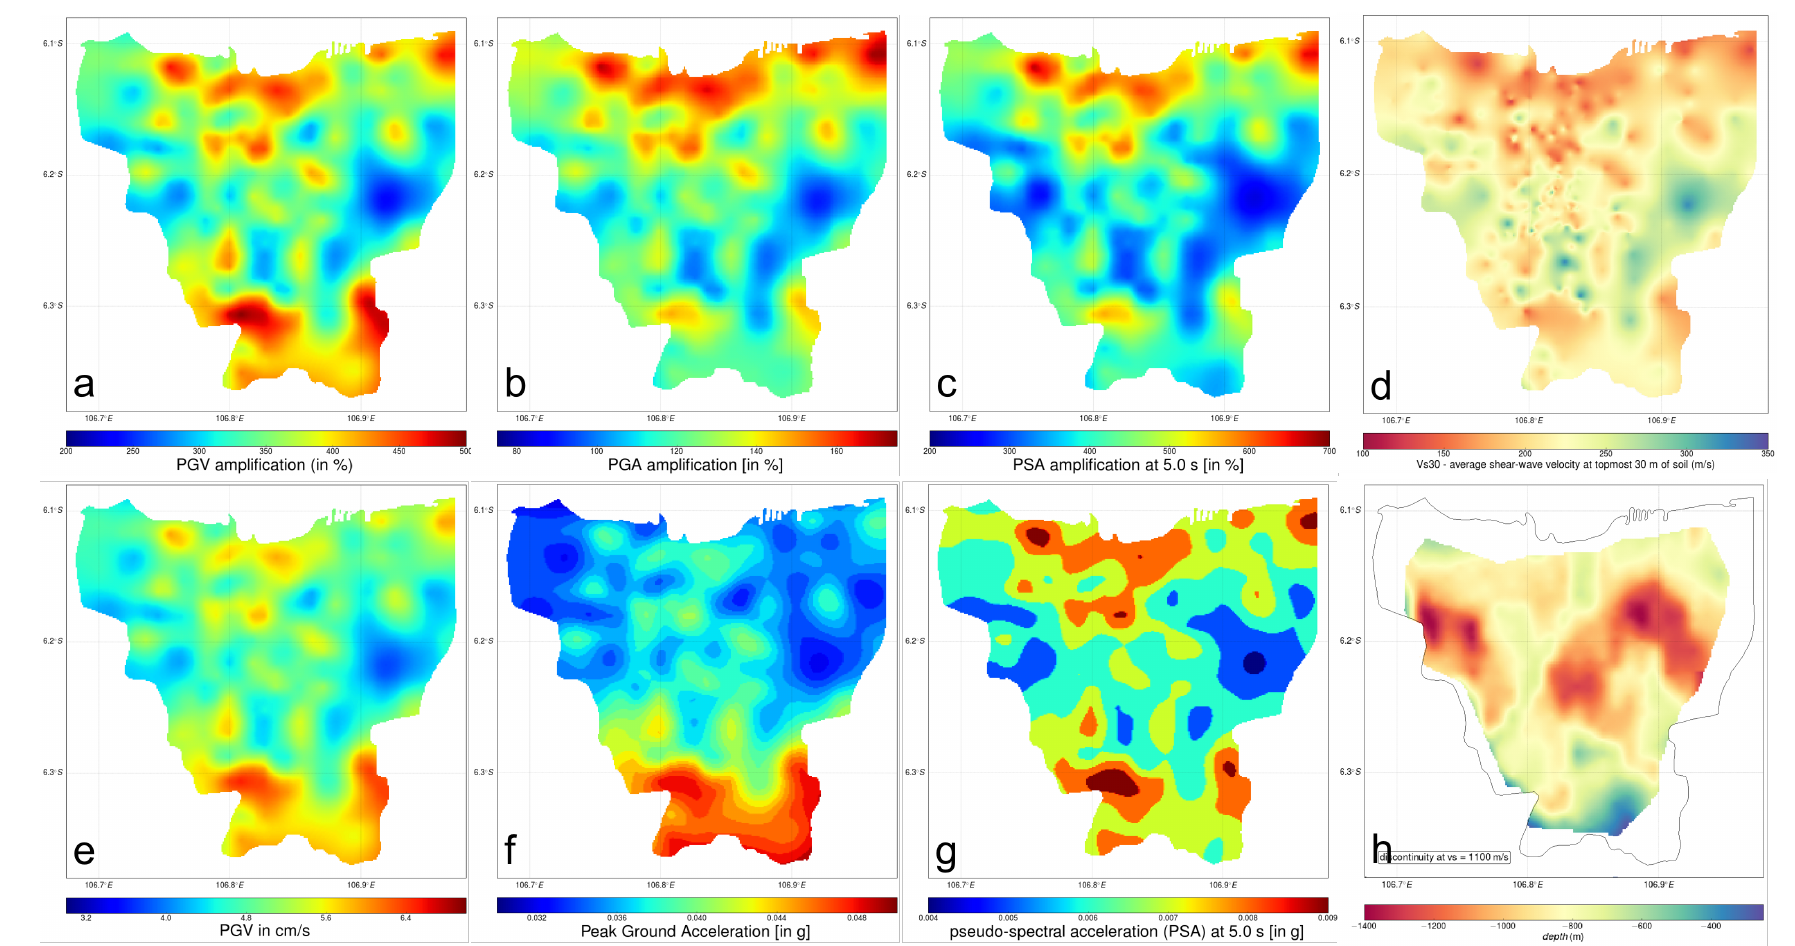
Figure 7. Results of GMPE modeling using CY2014 for the crustal earthquake scenario, and comparison with Jakarta Basin V S 30 and basin depth. ( a – c ) PGA, PGV and PSA 5.0 s, respectively calculated for the crustal earthquake scenario using CY2014 with the deep sediment correction Z 1.0 derived from the Jakarta Basin model of Cipta et al. [13]. ( d ) V S 30 derived form NSPT data (Ridwan [36]). ( e – g ) PGA, PGV and 5.0 s PSA amplification obtained by dividing the results in ( a – c ), respectively, by the corresponding calculations for hard rock. ( h ) A map of the Jakarta Basin depth from Cipta et al. [13], from which the Z 1.0 values for the deep sediment correction of CY2014 were